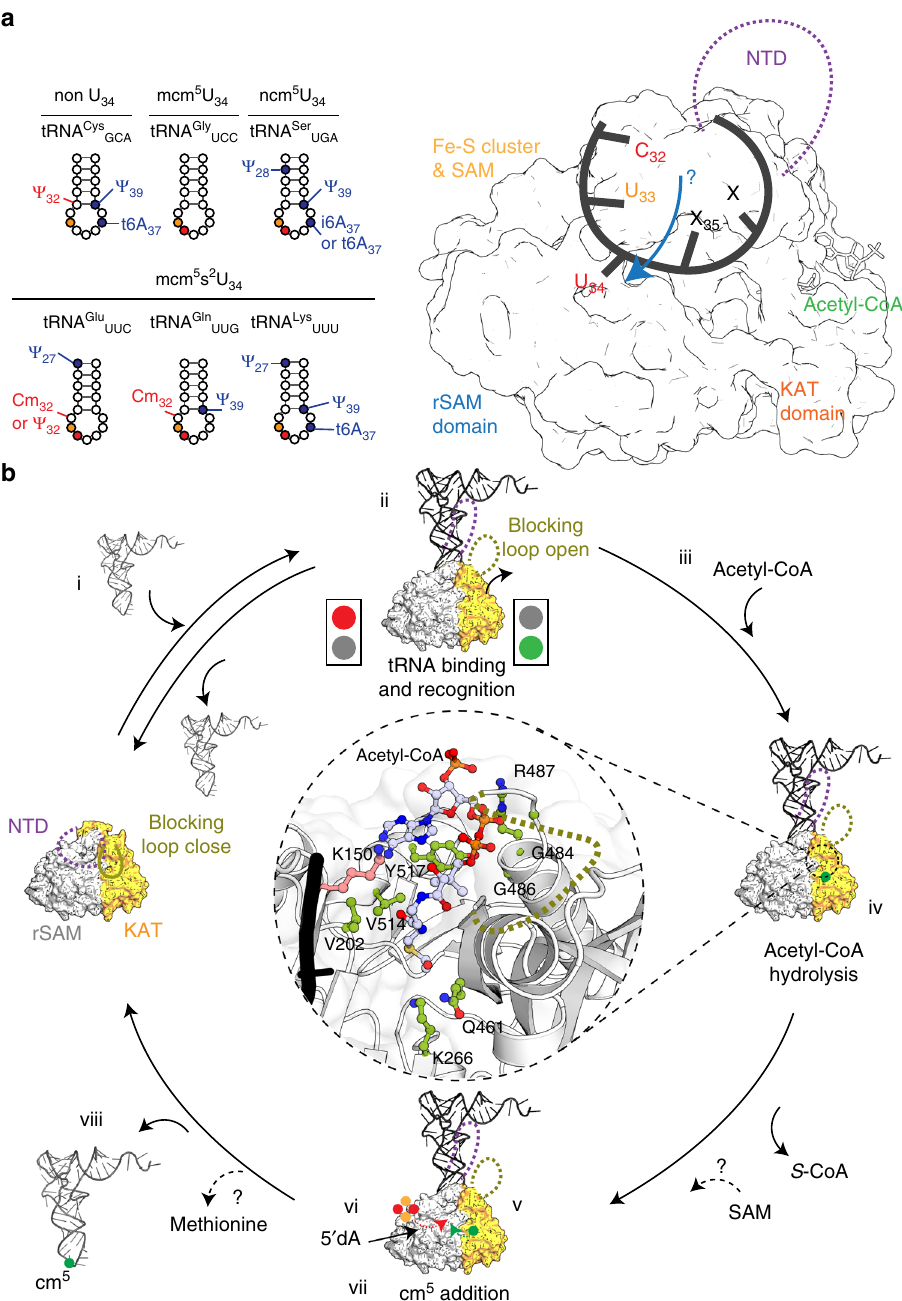
Fig. 5 Proposed structural rearrangements of Elp3 during tRNA modi fi cation. a (left) Experimentally proven modi fi cations in ASLs of different types of tRNAs. U 34 is shown as red circles and the invariable U 33 is shown as orange circles. Most common modi fi cations are indicated (blue) while the modi fi cations at position 32 of tRNA Glu UUC , tRNA Gln UUG , and tRNA Cys GCA are labeled in red. Ψ : pseudouridine; Cm: 2- O -methylcytidine; i6A: N6- isopentenyladenosine; t6A: N6-threonylcarbamoyladenosine. (right) The proposed in fl uence of priming modi fi cation on the cm 5 modi fi cation mechanism at U 34 (blue arrow). b Schematic overview of the individual sequential steps in the Elp3-mediated tRNA modi fi cation cycle. The N-terminus could change its location upon tRNA binding that regulates the position of acetyl-CoA blocking loop. The acetyl-CoA hydrolysis responsible residues (pink) and acetyl- CoA binding residues (green) are indicated in the inset. SAM is required for the catalytic reaction; however, the timing of SAM recruitment and release of the methionine by-product are still not clear (indicated by question